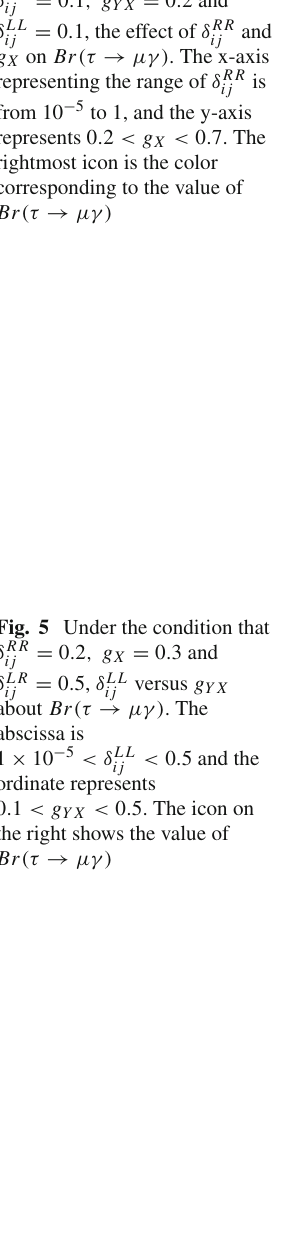
Fig. 5 Under the condition that δ RR = 0 . 2 , g = 0 . 3 and X ij δ LR = 0 . 5, δ LL versus g YX ij ij about Br (τ → μγ) . The abscissa is < 0 . 5 and the 1 × 10 − 5 < δ LL ij ordinate represents 0 . 1 < g YX < 0 . 5. The icon on the right shows the value of Br (τ →